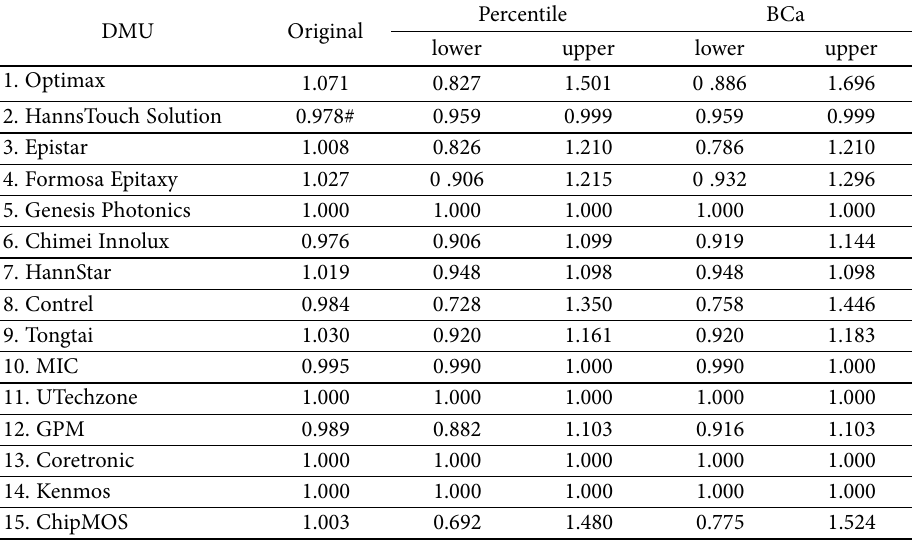
Table 15. Scale efficiency change with